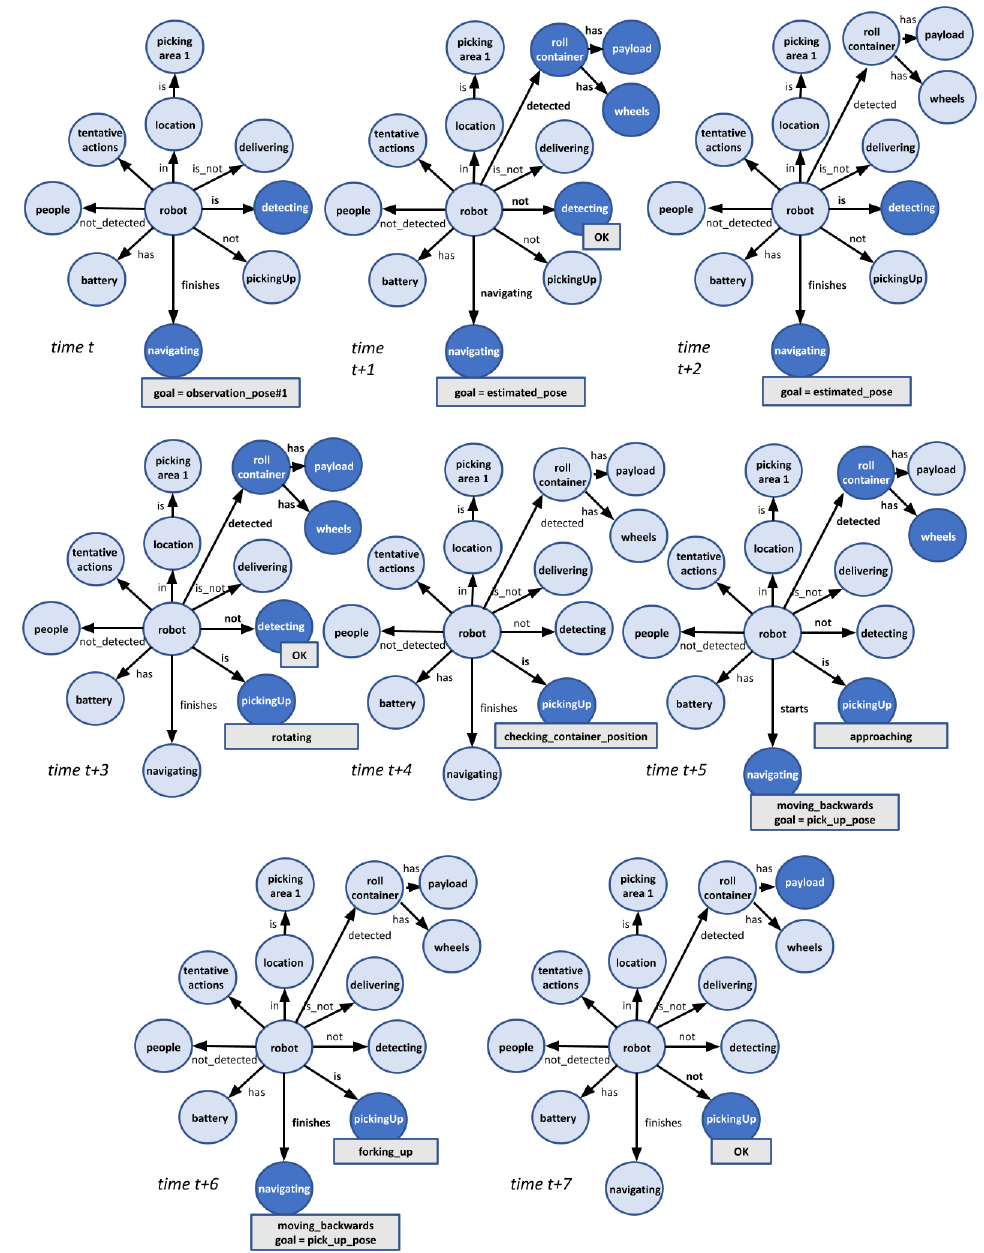
Figure 2. Evolution of the DSR for starting a picking up task. The robot at time t has just reaching the picking area 1 and the decision maker finishes navigating and starts the detection of the roll container. Different agents interact using the information stored in the DSR for launching and stopping their activities. The DSR at time t + 5 includes the roll container and shows that the robot starts navigating for approaching to the container (see text). In the graphs, dark blue and bold text are used to highlight changes from one step to the